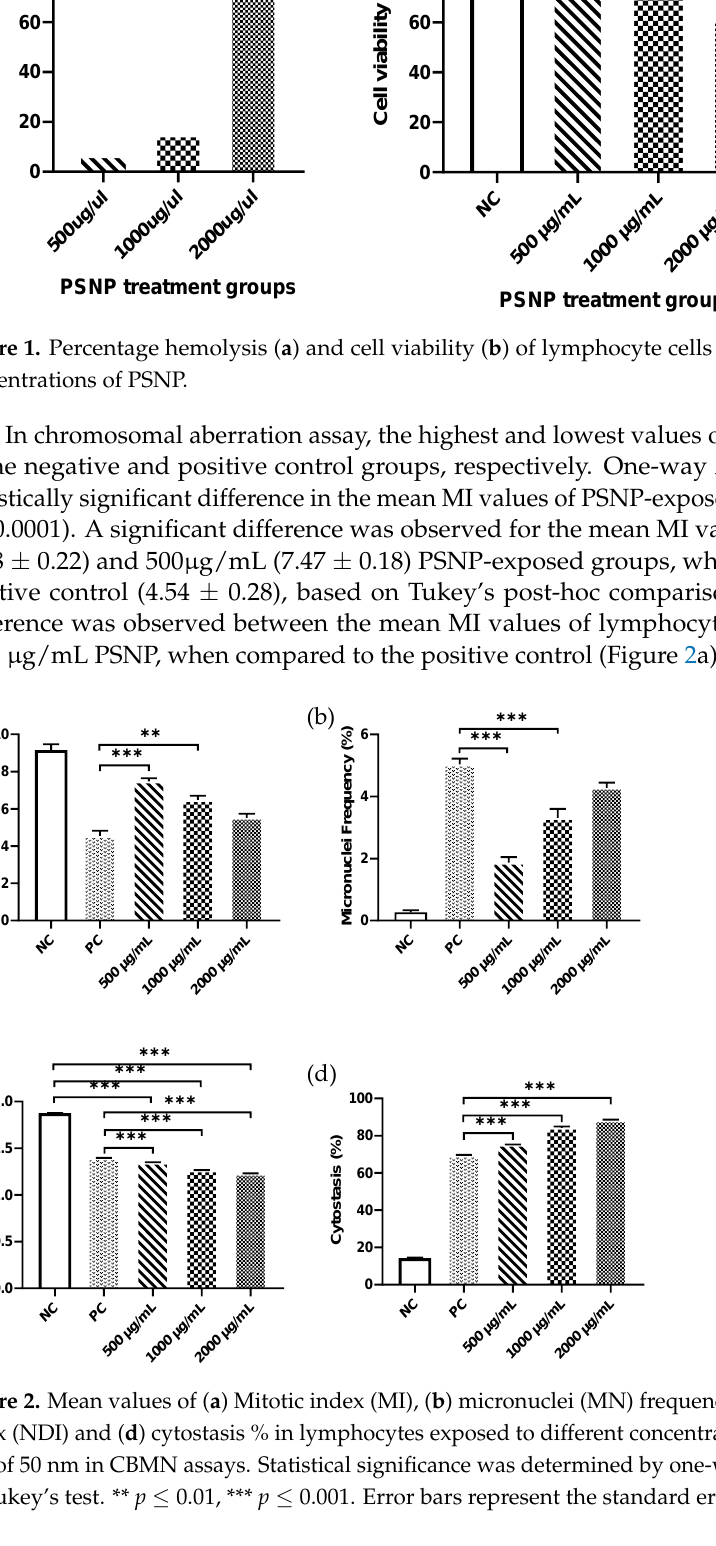
Figure 2. Mean values of ( a ) Mitotic index (MI), ( b ) micronuclei (MN) frequency, ( c ) nuclear division index (NDI) and ( d ) cytostasis % in lymphocytes exposed to different concentrations of PSNPs with